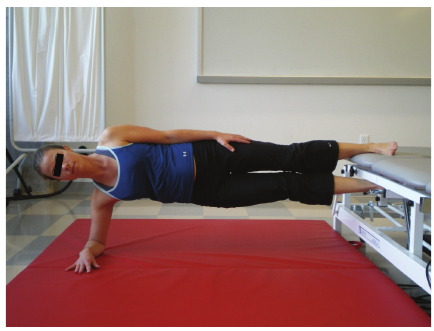
Figure 5: Medial stabilizing line